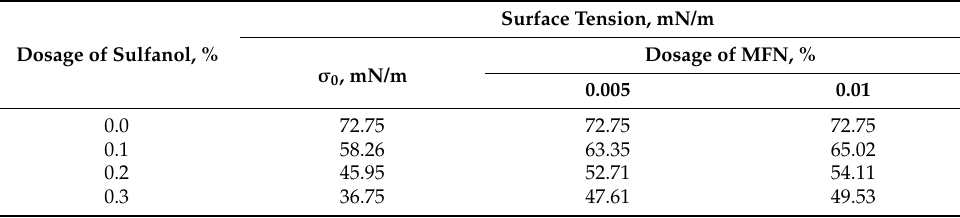
Table 3. Dependence of surface tension on the concentration of Sulfanol and MFN.